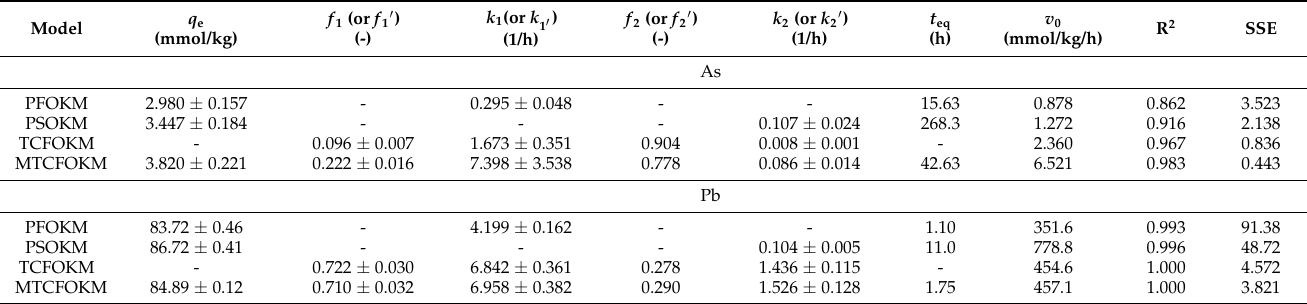
Figure 6. Adsorption kinetics of ( a ) As and ( b ) Pb onto SCM beads. Table 1. Parameters for adsorption kinetics of As and Pb onto SCM